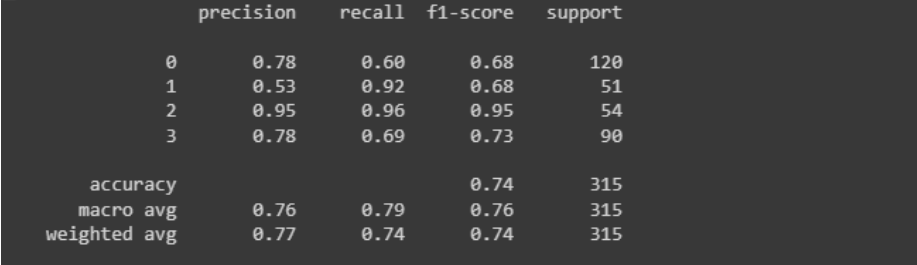
Figure 12. Classification report for the first model.